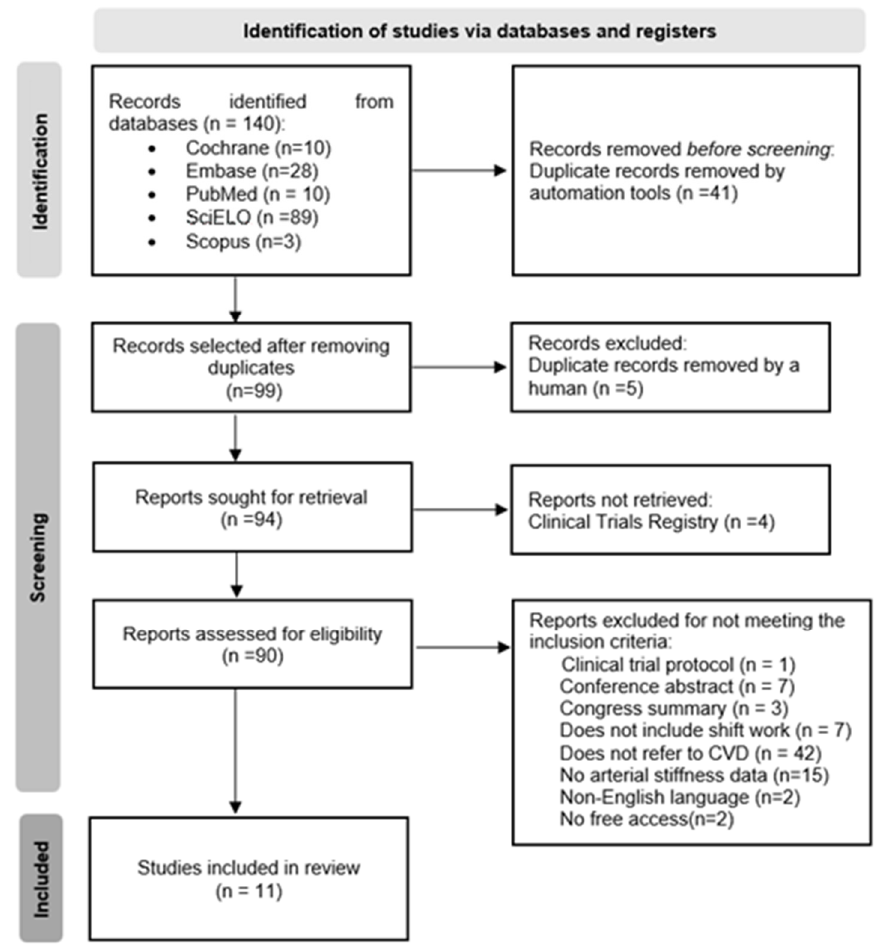
Figure 1. Flow diagram of process of search and selection of studies according to PRISMA criteria (Preferred Reporting Items for Systematics and Meta-Analyses).